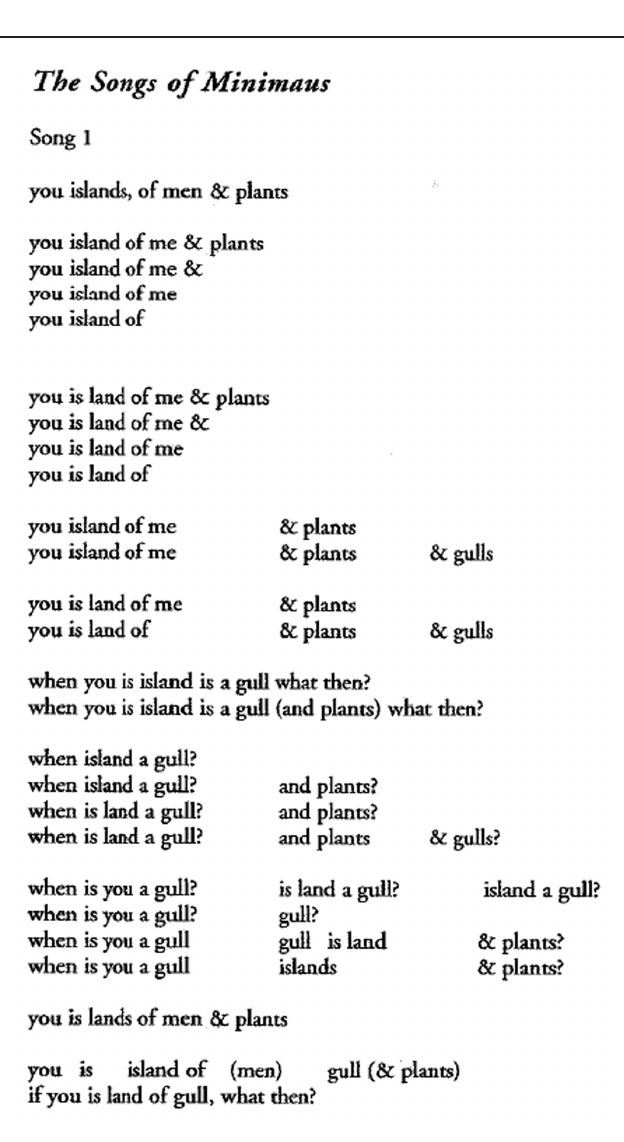
compressive qualities of digital storage; in the parlance of early millennium new media, to “crunch” a file is to reduce its size. Both interpretations reveal the “minimis- ing” impetus of “The Songs of Minimaus”, depicting a solipsistic turn inwards whose impulse is reduction and compression. Hence “all over everything” becomes Olsen’s